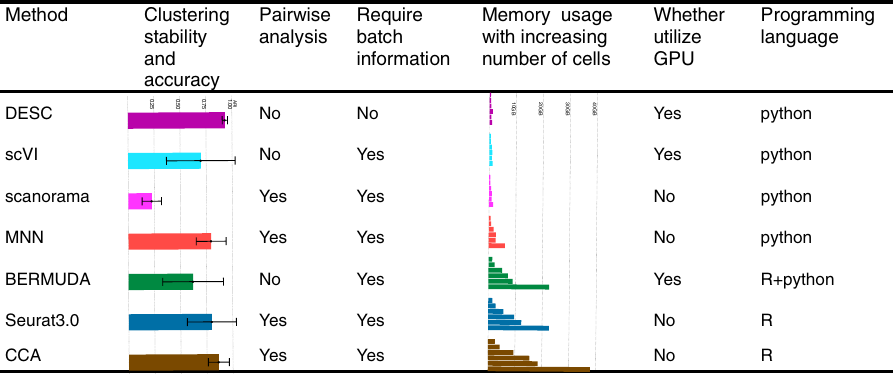
where z i ¼ f W x i ð Þ 2 Z corresponds to x i 2 X after embedding, and α is the degree of freedom of the Student ’ s t distribution. We also evaluated the performance of Gaussian distribution as a kernel, but found it to be less robust than the t distribution (Supplementary Note 3). In the second step, we re fi ne the clusters by learning from cells with high con fi dence cluster assignments with the help of an auxiliary target distribution.